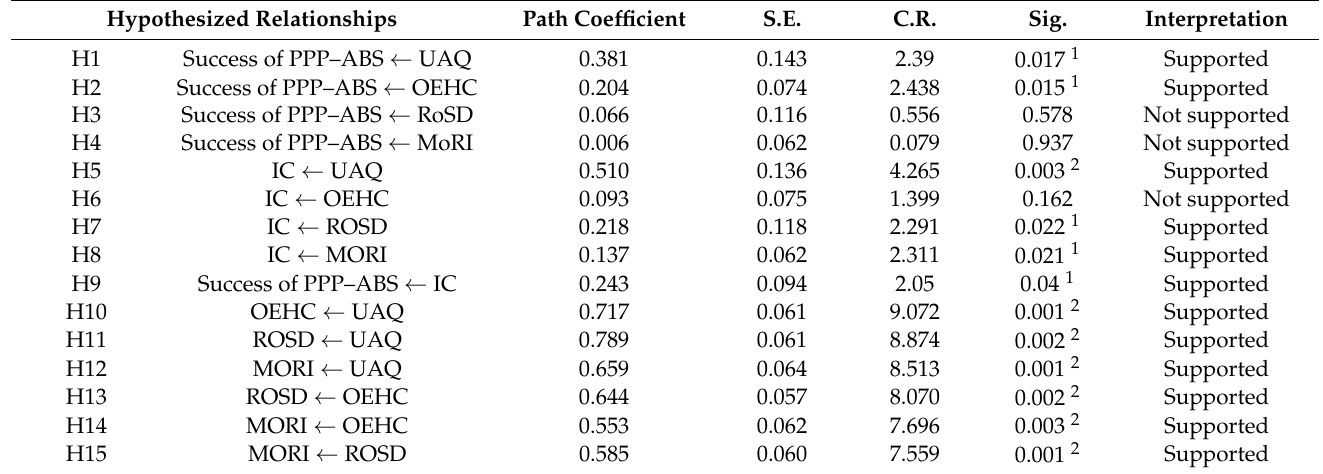
Table 7. Results of path analysis (Source: Authors’